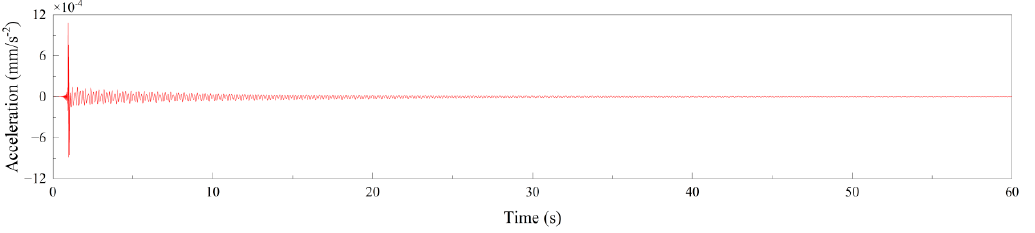
Figure 21. Acceleration time history in flap-wise direction.